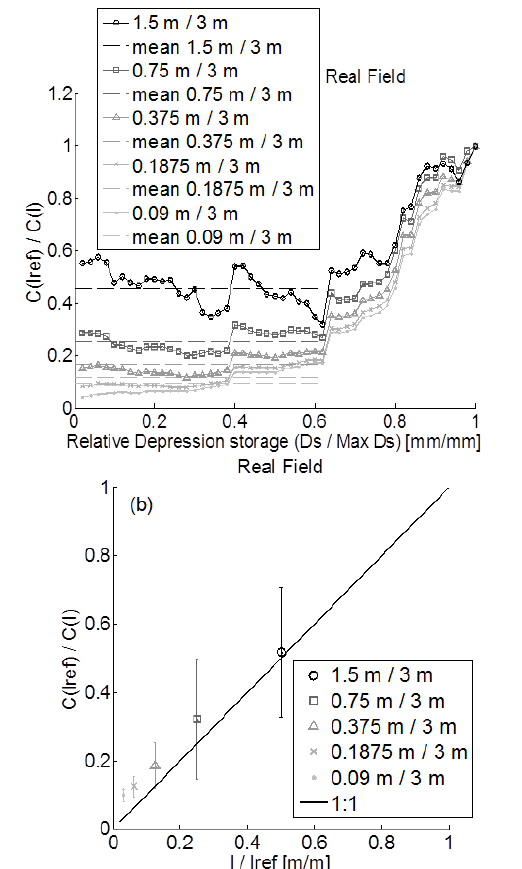
Fig. 15. Real field – scale effect when changing the length: (a) ra- tio of connectivities at different scales as a function of the relative depression storage. Horizontal dashed lines correspond to the mean value of the connectivity ratio calculated over the range RDS=0 to RDS=0.62. (b) Correlation between the scale ratios and the ratios of connectivities for the first two thirds of the RSC function. Vertical lines=standard deviation. All the plots are 3m